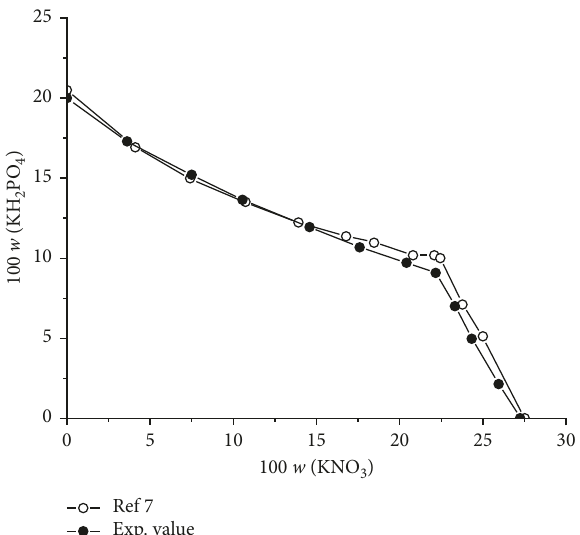
2 PO 4 +KNO 3 +H 2 O Figure 6: Comparison of the KH aqueous solutions and at cosaturated points T, D, and